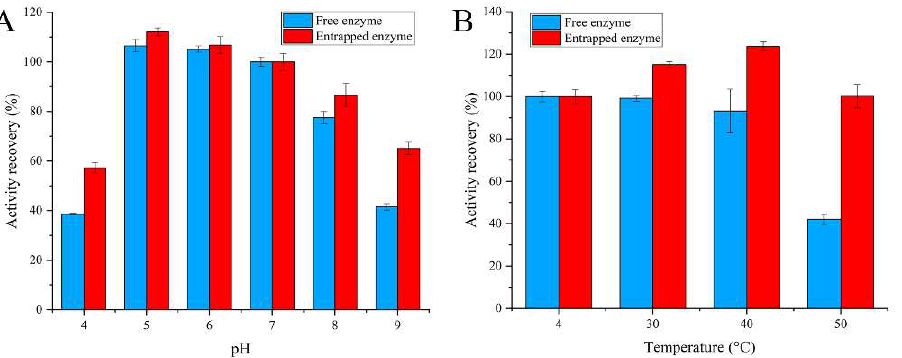
Figure 3. Stability of entrapped glucose oxidase: ( A ) stability of pH; ( B ) stability of temperature.